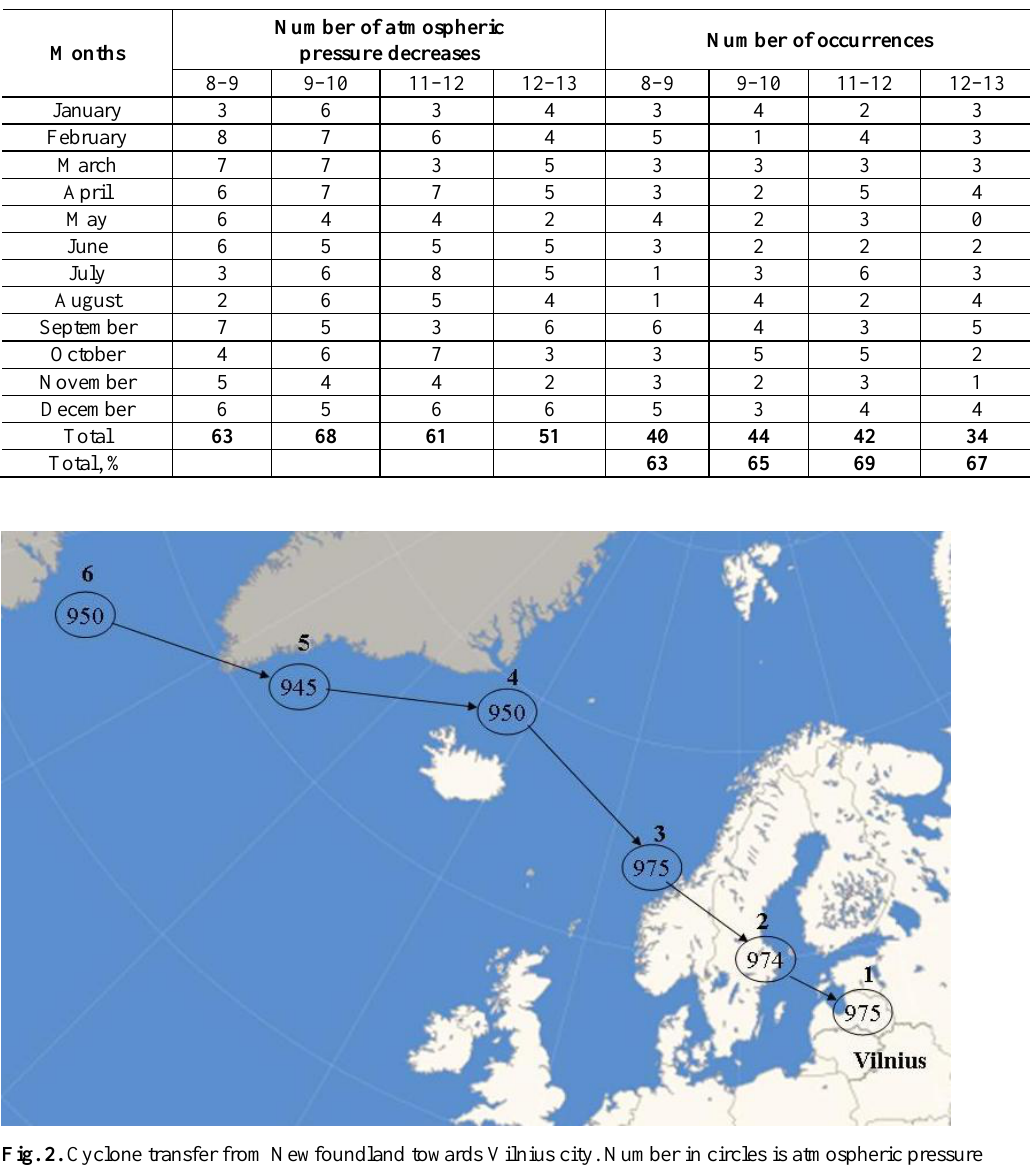
Table 4. Efficiency of prognostic connection between HCRF decrease at 1.2–1.6 MeV energy interval and atmospheric pressure decrease at various time intervals in Vilnius in 2005